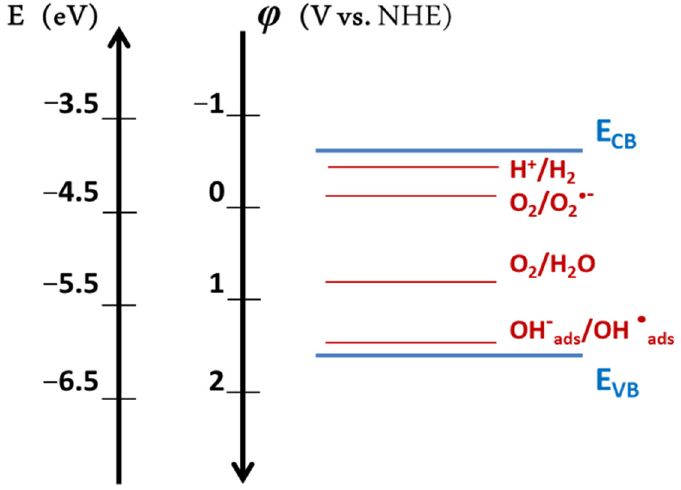
Figure 11. Scheme presenting energy and potential diagram correlating the conduction band (CB) and valence band (VB) levels of CdS and different redox couples that can be responsible for photocatalytic decomposition of MB and TC, pH=7.